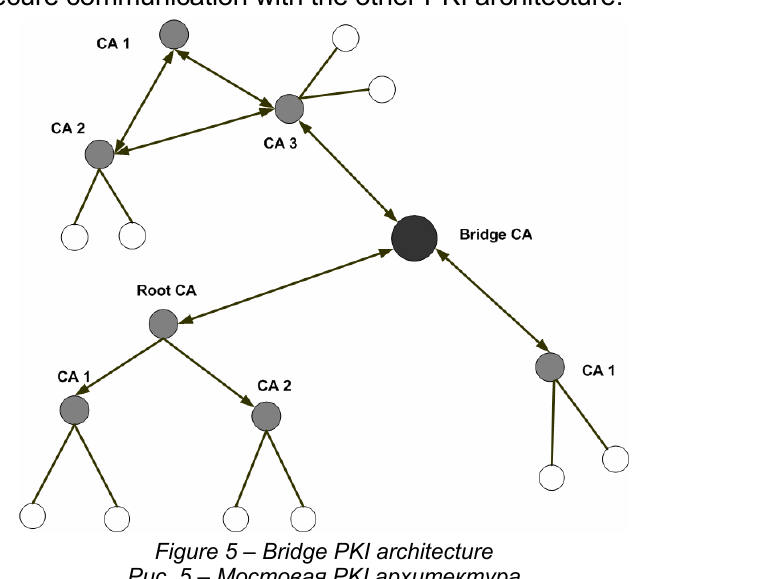
Figure 5 – Bridge PKI